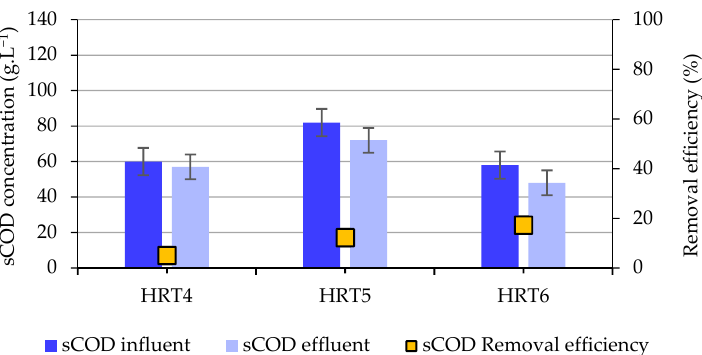
Figure 6. Average concentrations ( n = 3 samples per HRT) of total COD in the influent (tCOD influent) and effluent (tCOD effluent) of the bioreactor, and respective removal efficiencies (error bars: standard deviation) (concentrations: on the left y axis; removal efficiencies: on the right y axis).